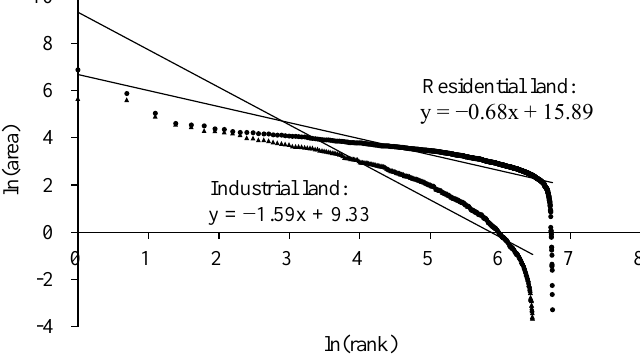
Figure 3. Rank-size curves of industrial and residential land in Xintai.